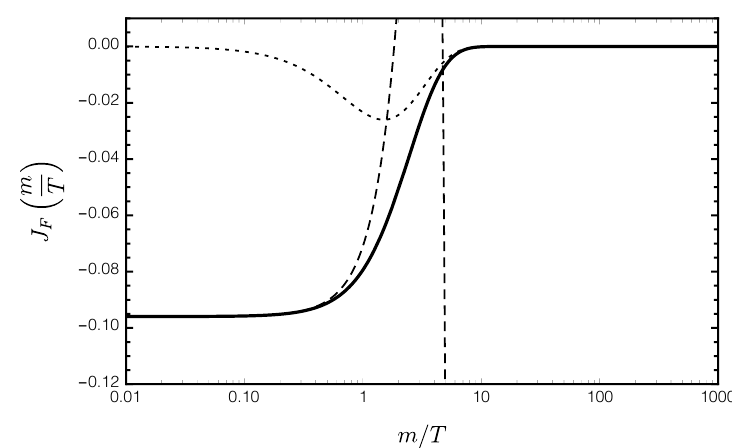
Figure 2: This figure shows the dimensionless function J that is proportional to the F free energy of fermions as defined in Eq. (2.27) as a function of mass-to-temperature ratio (thick line). Additionally, the expansion for large T (dashed), Eq. (2.28) and small T (dotted) , in analogy to Eq. (2.20) are shown. Note that in the small T limit, both the fermionic and the bosonic expansions agree. The large T expansion is performed up to order four in m / T , working well up to m / T ∼ 0.5, hence being sligthly worse than the bosonic high-T expansion, depicted in Fig. 1